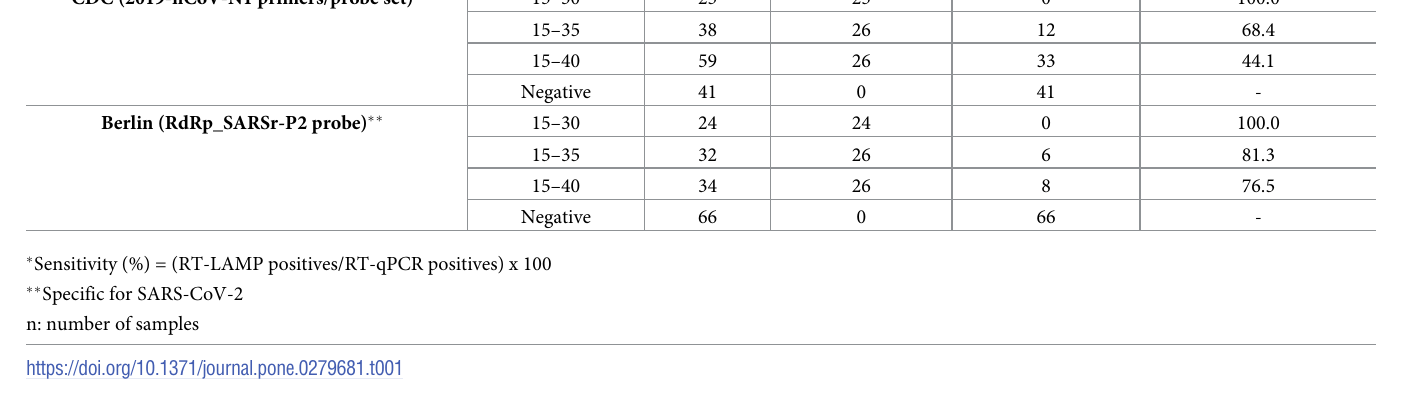
Table 1. Comparison of SARS-CoV-2 detection by RT-LAMP and RT-qPCR (CDC and Berlin protocol-based methodologies) in saliva samples. RT-qPCR Colorimetric RT-LAMP Protocol-based